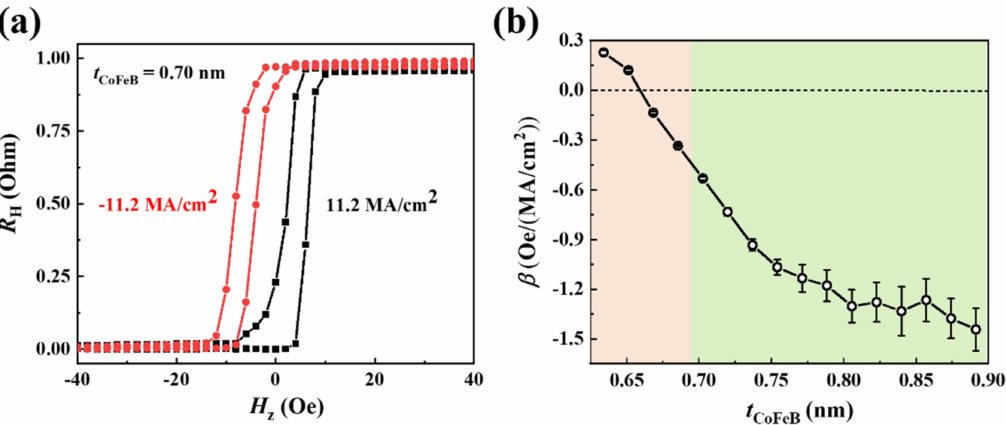
Figure 3. Current-induced out-of-plane effective magnetic fields measured using loops-shift methods. ( a ) Out-of-plane hysteresis loops under opposite current polarities for t CoFeB = 0.70 nm. ( b ) β as a function of CoFeB thickness, where the full field-free SOT switching only can be found in the green